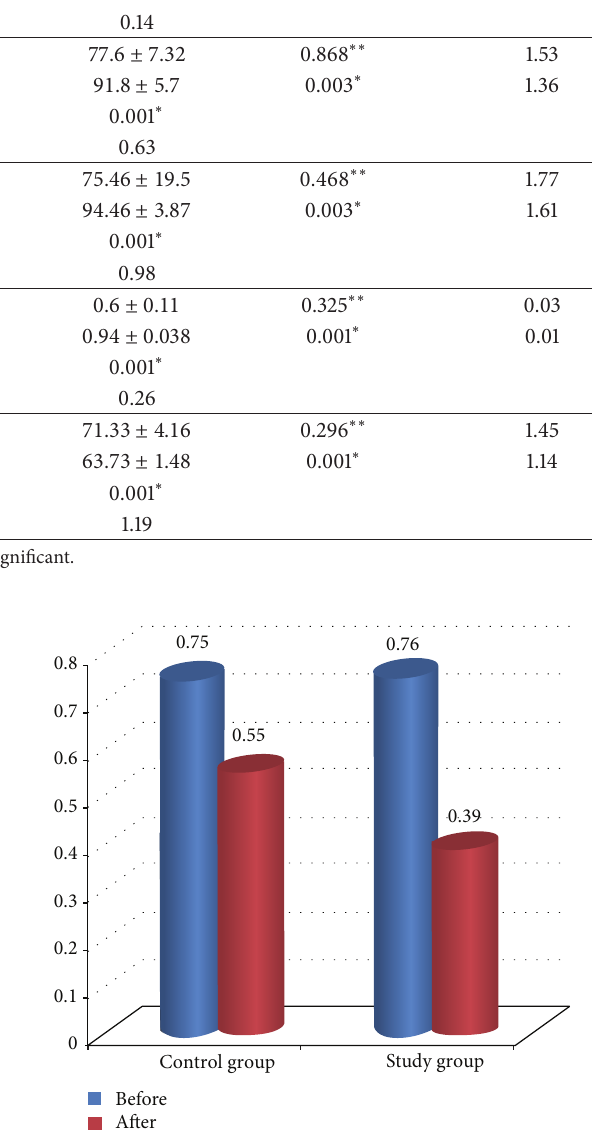
is a strong clinical indicator for hamstring muscle tightness and needed for surgical intervention. Stride length, stride speed, and stance phase percentages were measured by 3D gait analysis as indicator of program effect on gait